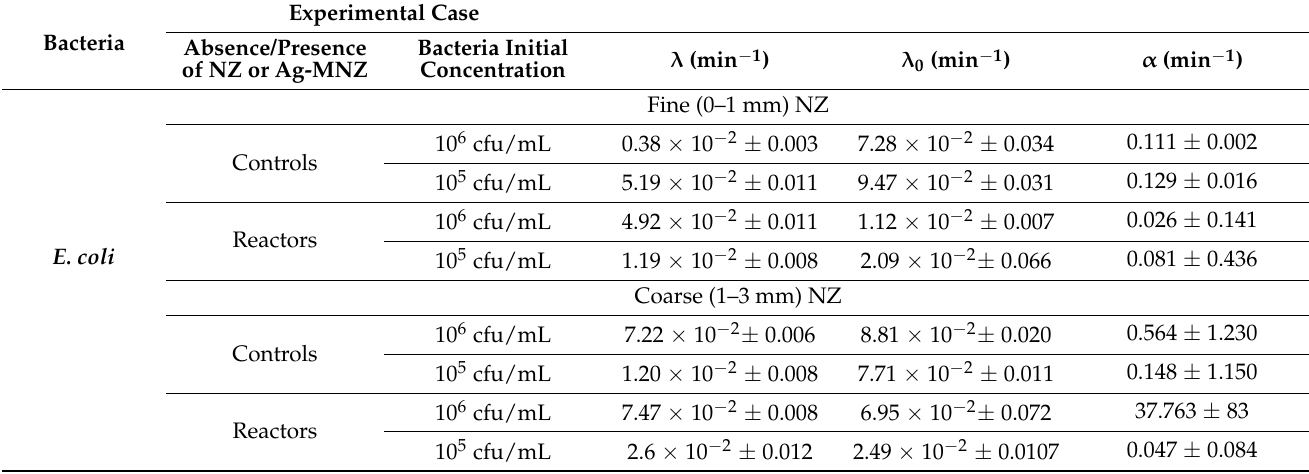
Table 1. Fitted inactivation parameter values ( λ , λ 0 , and α ) of E. coli and E. faecalis for the two initial concentrations (10 6 and 10 5 cfu/mL) under experimental